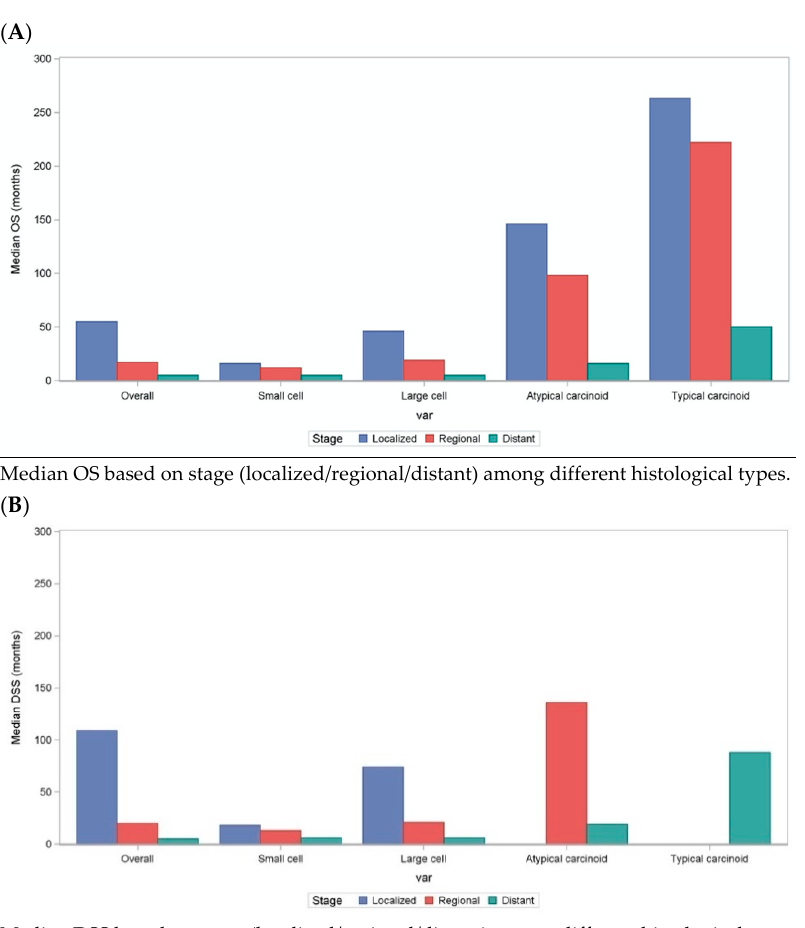
Figure 3. ( A ) Median OS among lung cancer patients based on different stages among different histological type. ( B ) Median DSS among lung cancer patients based on different stages among different histological type. On multivariable analysis, the median overall survival (OS) and disease-specific survival (DSS) rate varied significantly by stage, age at diagnosis, histological type, insurance type, marital status, and race.